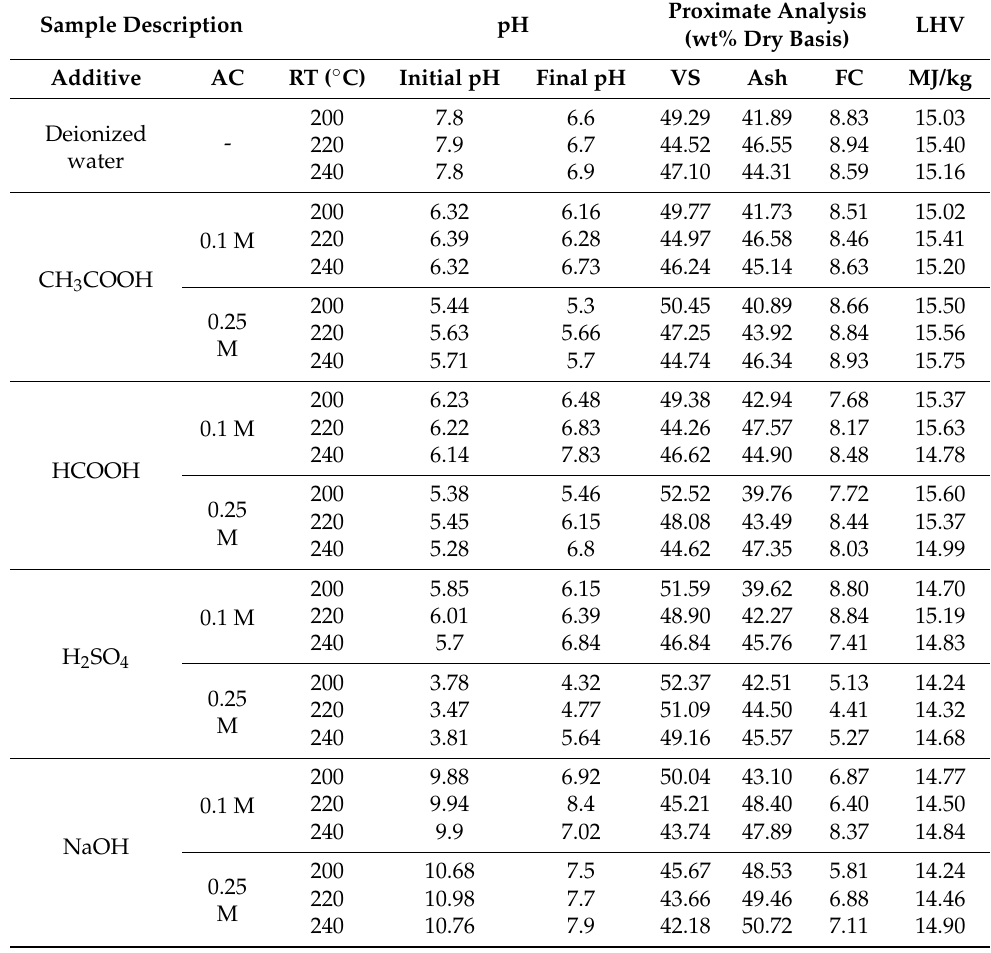
Table 2. Proximate analysis and heating value of hydrochar produced using various additives and reaction conditions. (AC-Additive concentration; RT-Reaction temperature; Initial and final pH represents the pH of feedstock slurry before and after HTC. All hydrochars were produced at 2 h retention